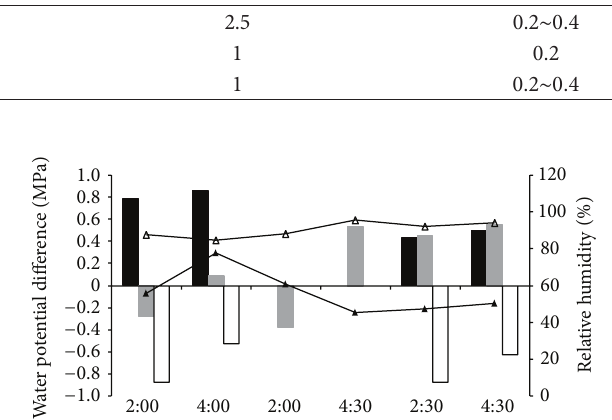
Figure 3: Water potential difference and air relative humidity at specific moments over three days. Black bars show the difference in leaf water potential of T. ramosissima between the treatment group and control group; gray bars and nonfilled bars show the water potential differences between leaves and shoots for treatment and control groups, respectively. Line with hollow triangle shows RH in the chamber and line with solid triangle shows RH under natural conditions.